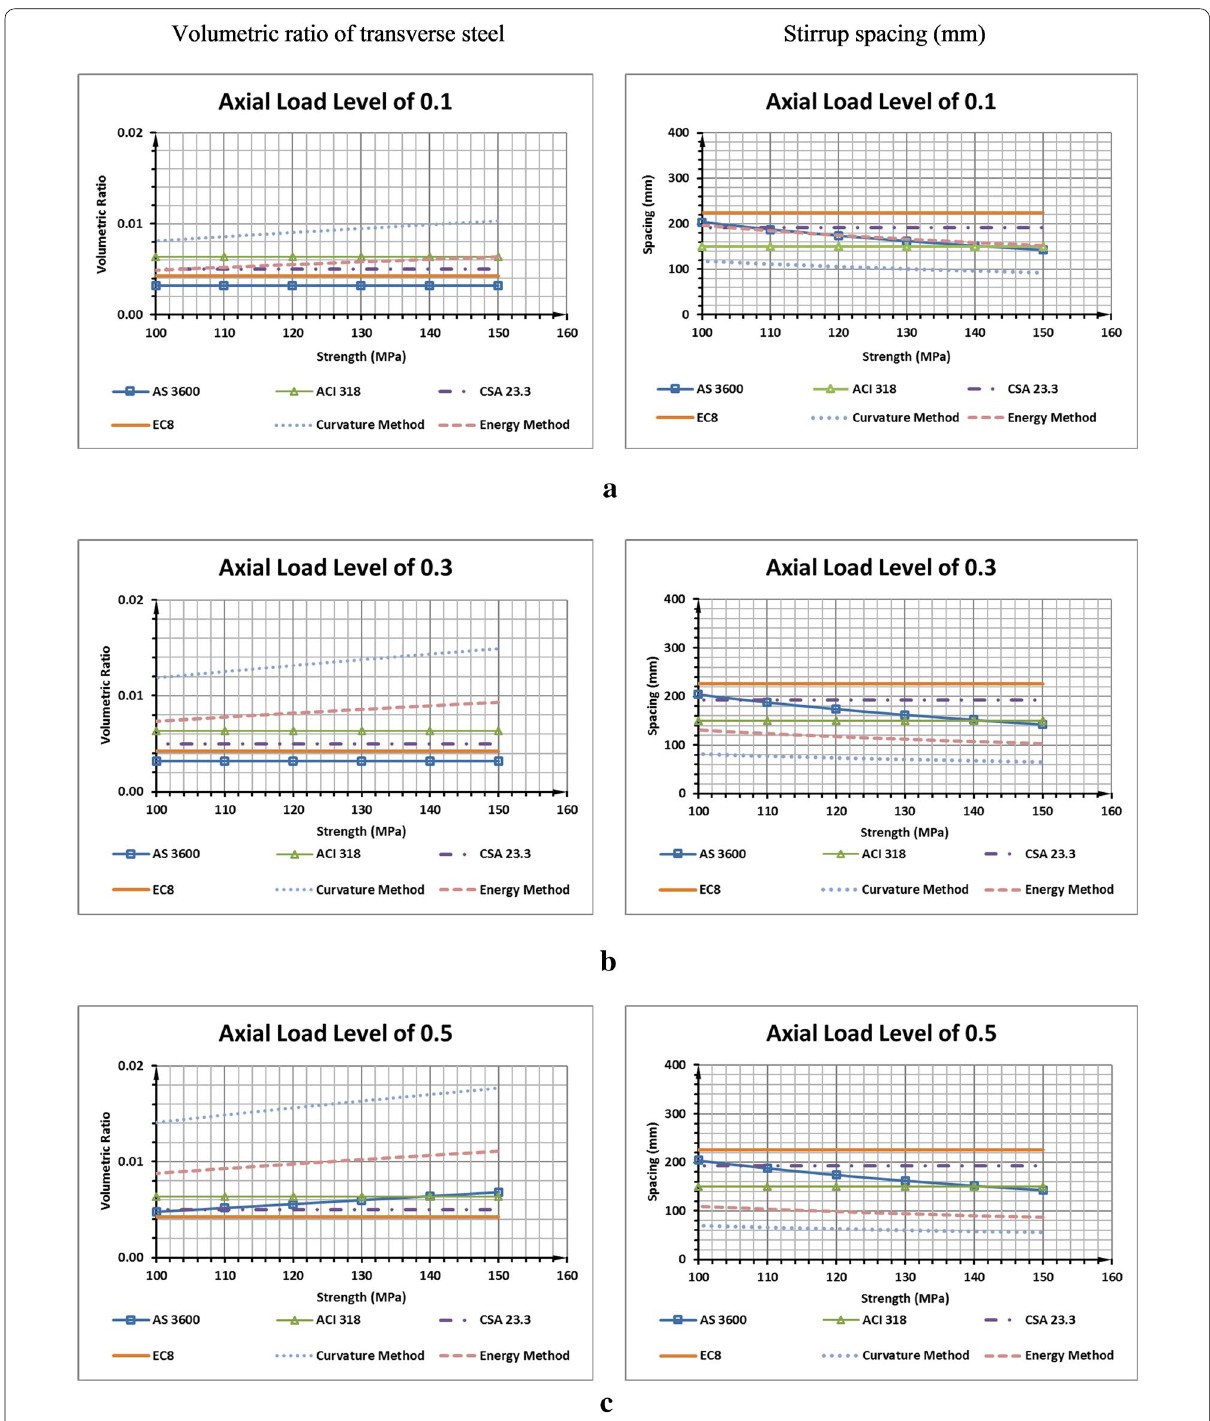
Fig. 13 Required volumetric ratio of transverse steel and stirrup spacing ( ρ sl f co A c 0.3, c P /f co A c =